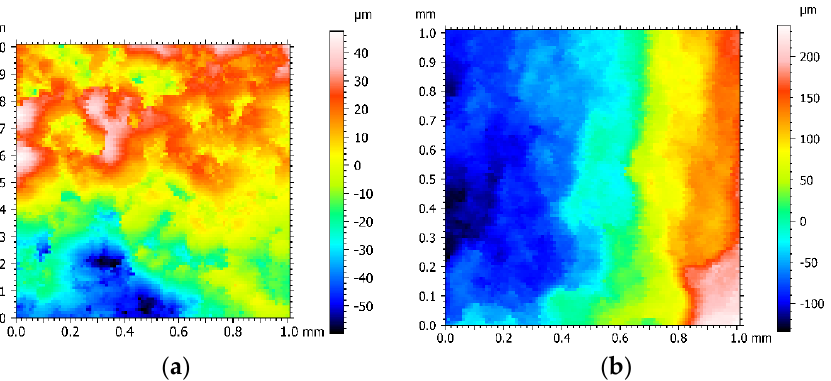
Figure 6. Scanning results for 316L stainless steel: ( a ) surface topography in air; ( b ) surface morphology in 5wt% NaCl.